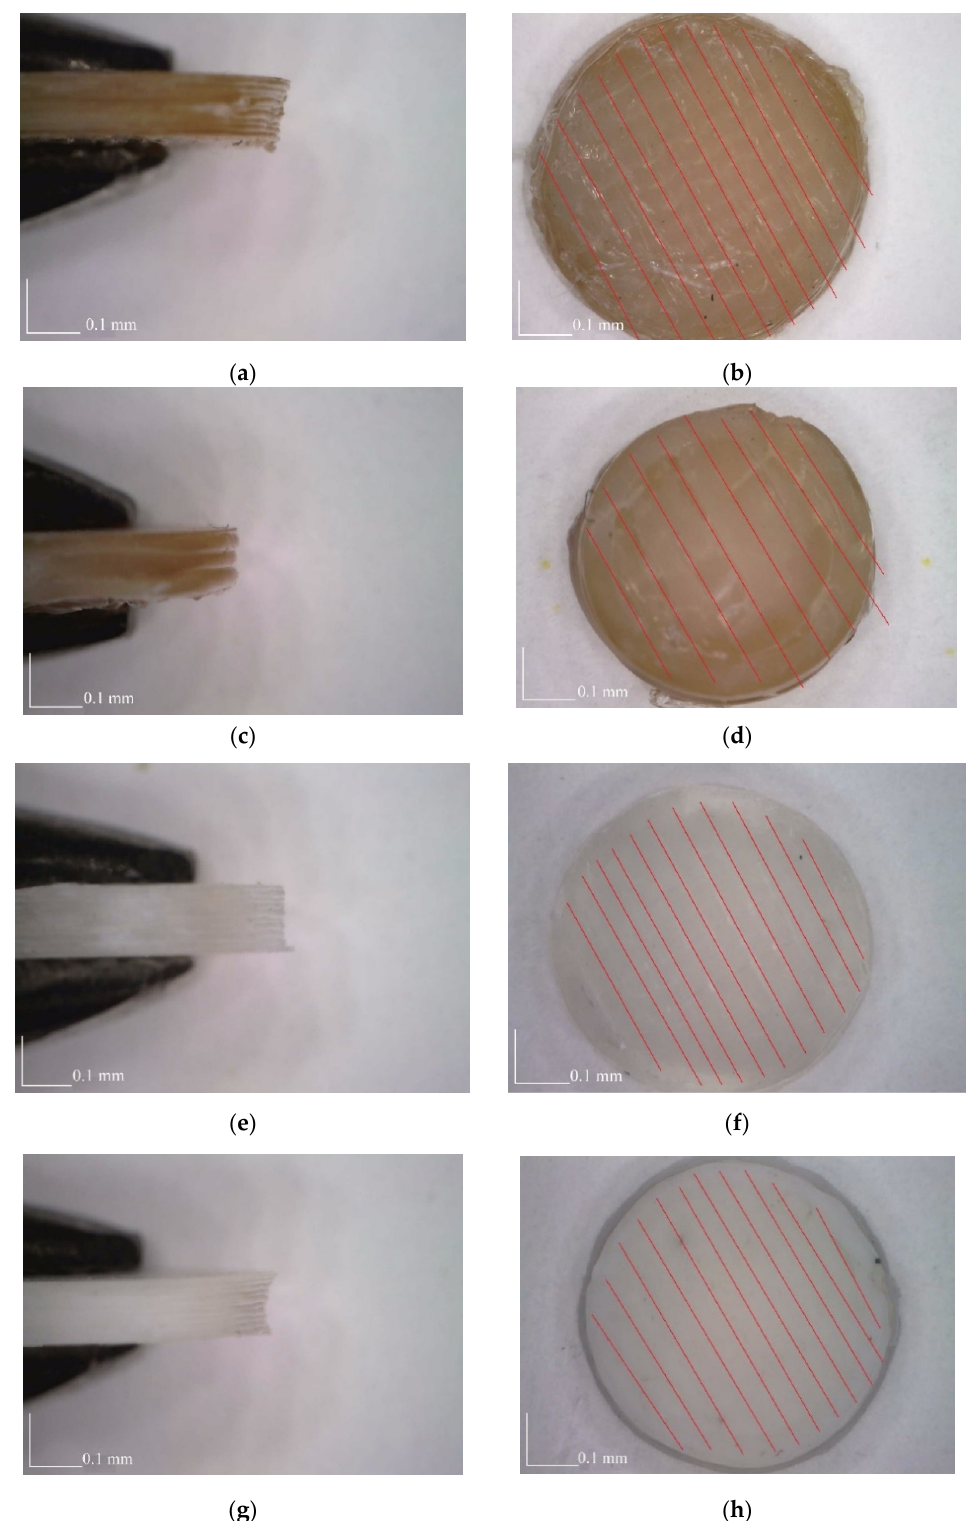
Figure 3. Printed samples: ( a , b ) PEEK 04-01; ( c , d ) PEEK-06-03; ( e , f ) PLA 04-01; ( g , h ) PETG 04-01 (( a , c , i , g )—side views; ( b , d , f , h )—top views).